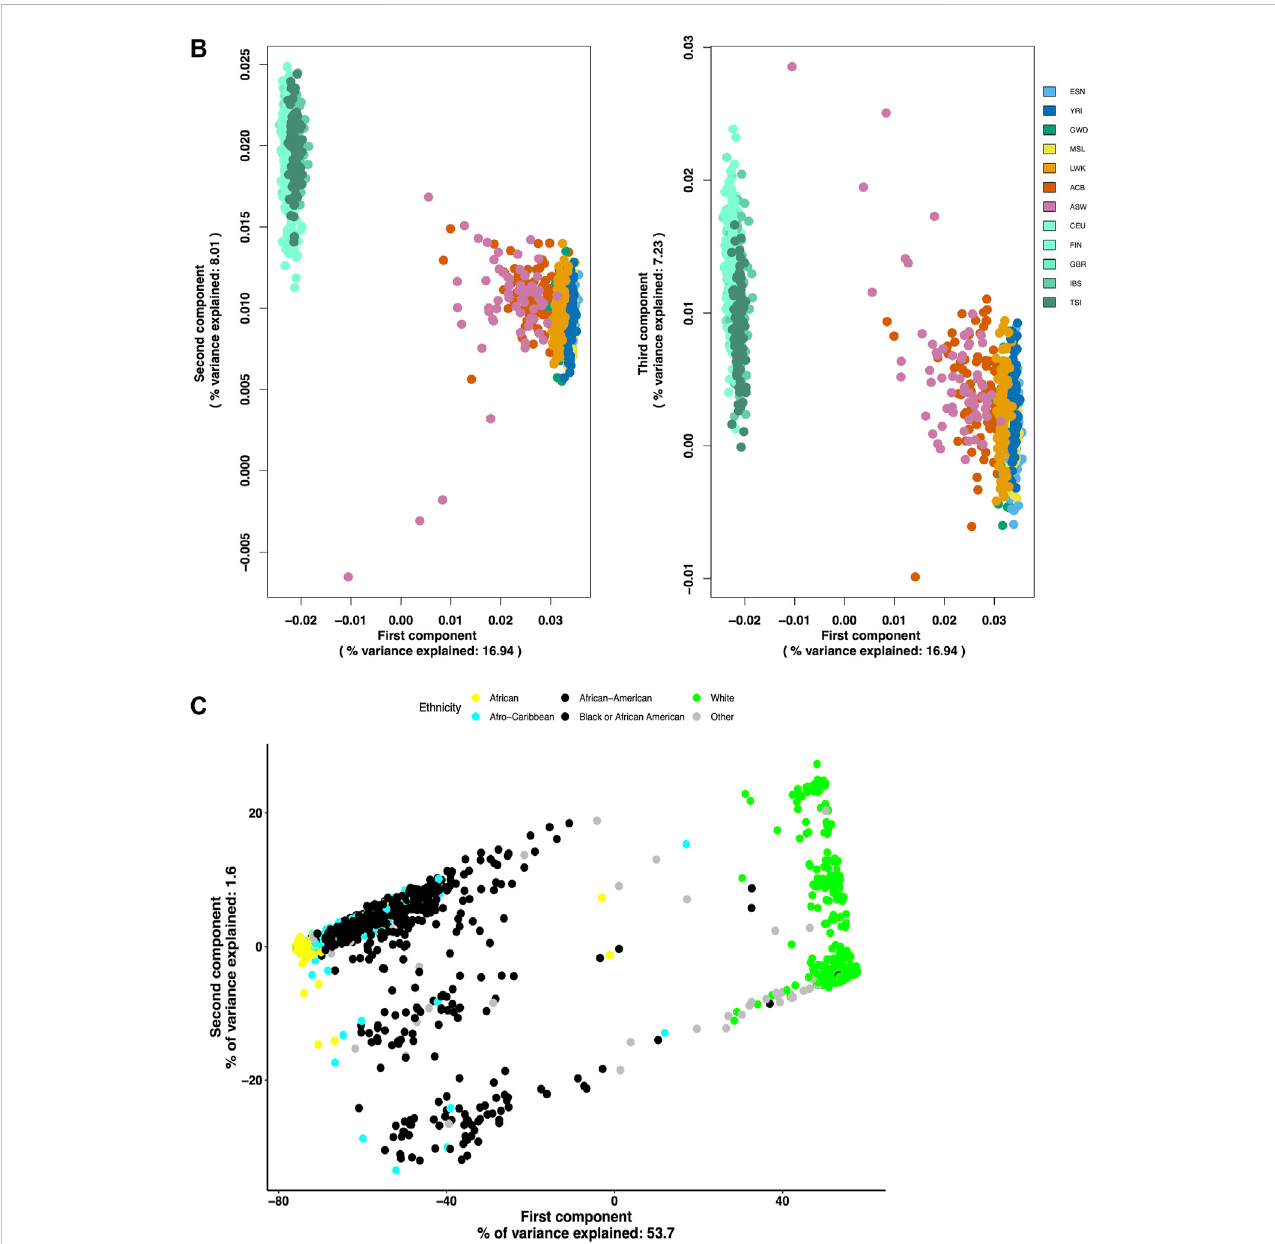
FIGURE 4 Clustering of African AIMs within and between populations. (A) Principal component analysis across all subpopulations in 1000 Genomes Project data with populations of high African ancestry in individual colors while the other subpopulations are colored in a single-color gradient (EUR: aquamarine; EAS: green; AMR: yellow; SAS: purple). (B) Principal component analysis of the AFR subpopulations (multicolor), plus the Afro-Caribbean (ACB), the African American (ASW), and the EUR subpopulations. (C) PCA of 9,385 AIMs genotyped in an independent dataset with PC1 explaining 53.7% of the genetic variance in the